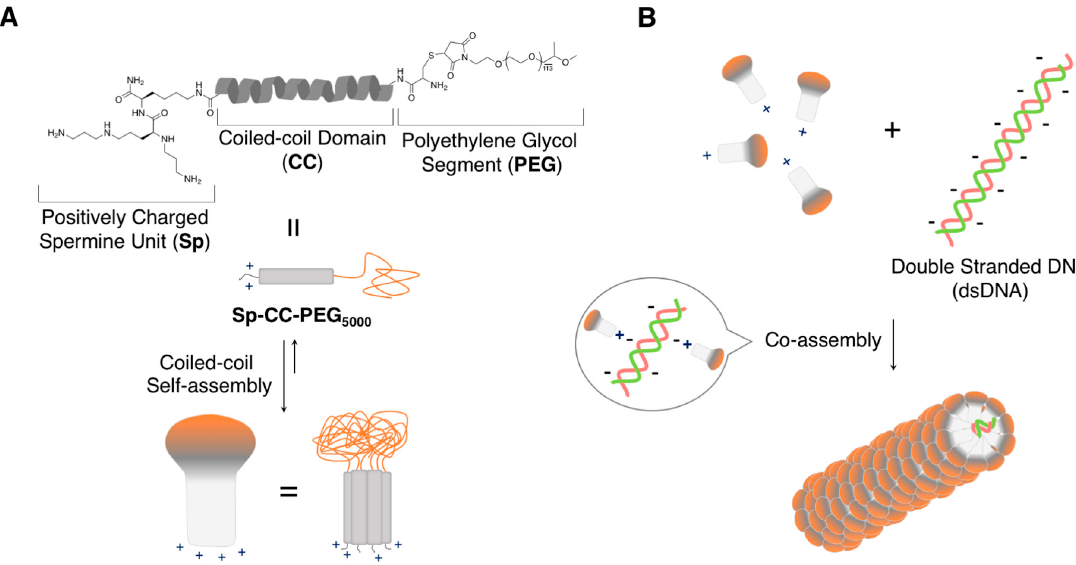
Figure 5. ( A ) Design of SP-CC-PEG to form mushroom-shaped nanostructures. ( B ) Schematic illustration of the formation of supramolecular rod-like nanostructures through the complexation of with dsDNAs. Adapted from [66]. Copyright 2013 American Chemical